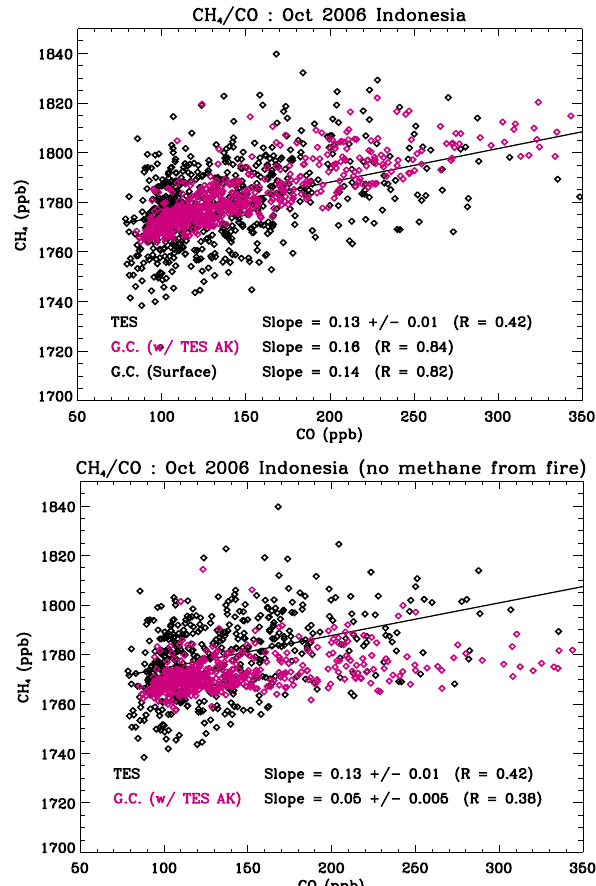
Fig. 9. (a) Distribution of CH 4 and CO over Indonesian fires. The TES data are shown in black. The GEOS-Chem data (adjusted with the TES operator) are in red. A linear fit to the TES data is shown as a black line. (b) Same as (a) but Indonesian CH 4 biomass burning emissions have been set to zero for October